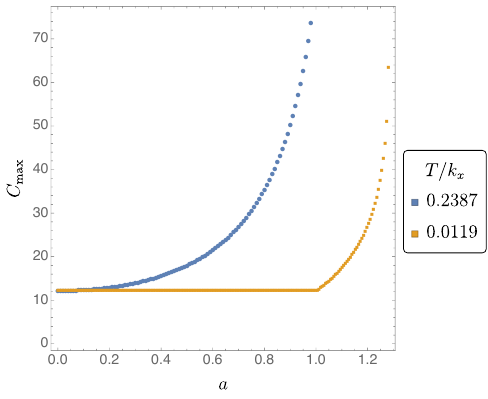
Figure 19 . C max as a function of a , depicted for T=k X = 0 : 2387 (top curve) and T=k X = 0 : 0119 (bottom curve). The kink in the bottom curve corresponds to the interchange of two local maxima.